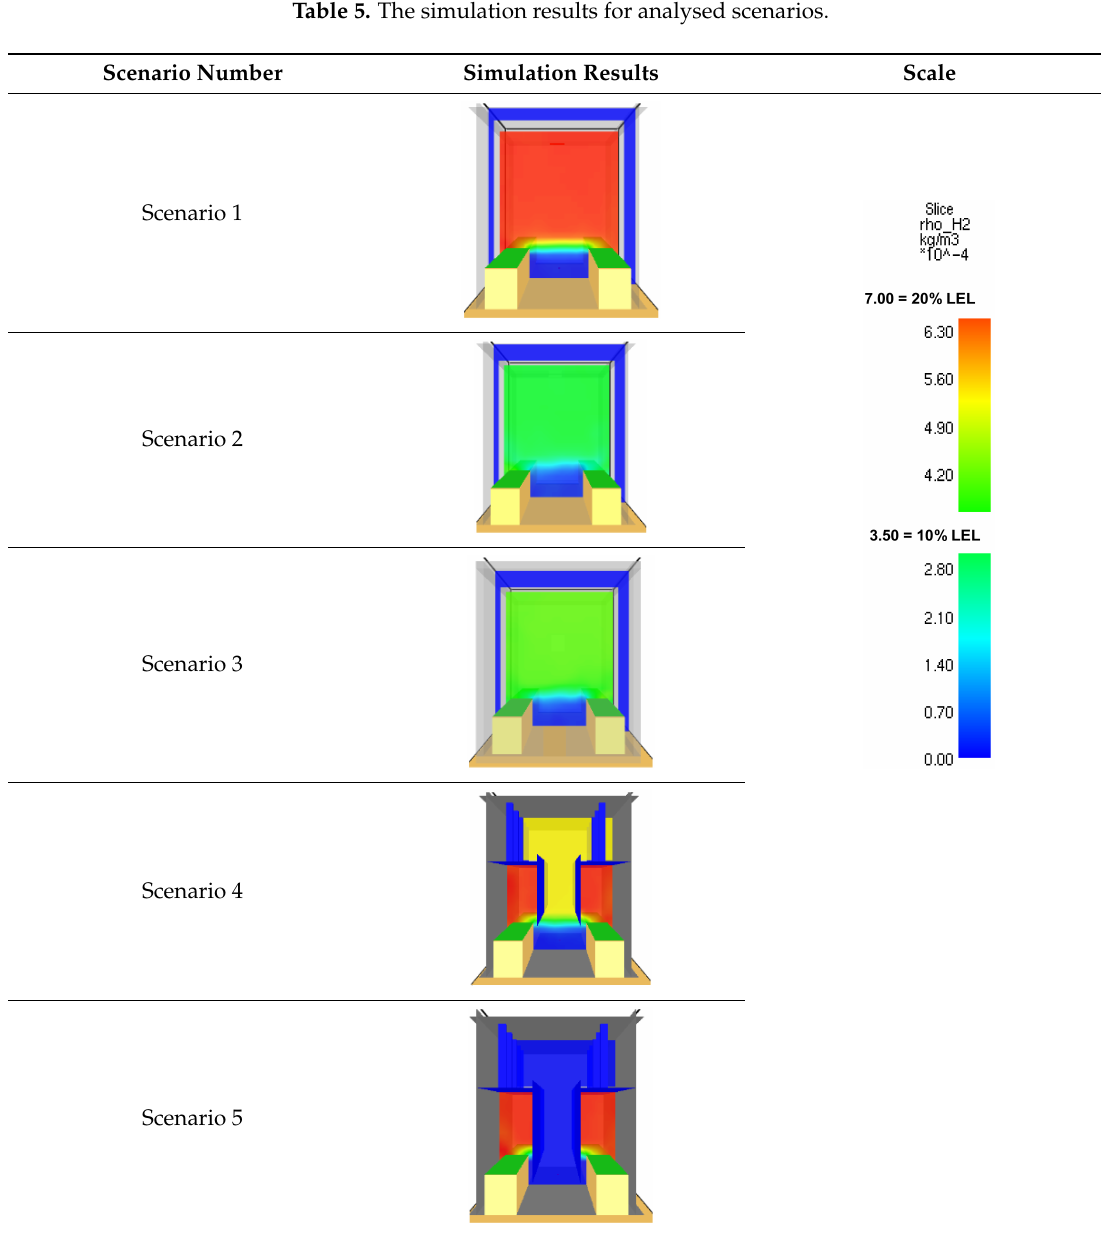
Table 5. The simulation results for analysed